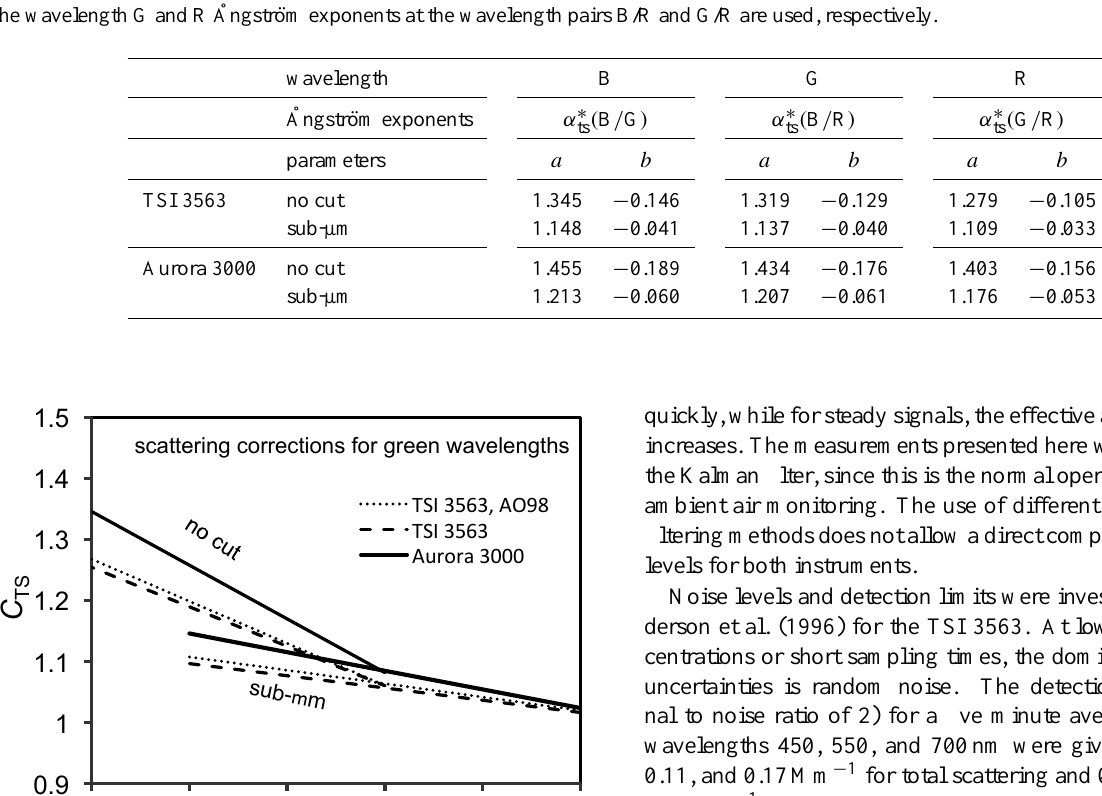
Table 3b. Correction factors for total scatter as function of ˚Angstr¨om exponent: C ts = a + b × α ∗ ts . For correction of scattering coefficients for the blue (B) wavelength the ˚Angstr¨om exponent calculated from uncorrected scattering coefficients of blue and green (B/G) is used. At the wavelength G and R ˚Angstr¨om exponents at the wavelength pairs B/R and G/R are used, respectively.